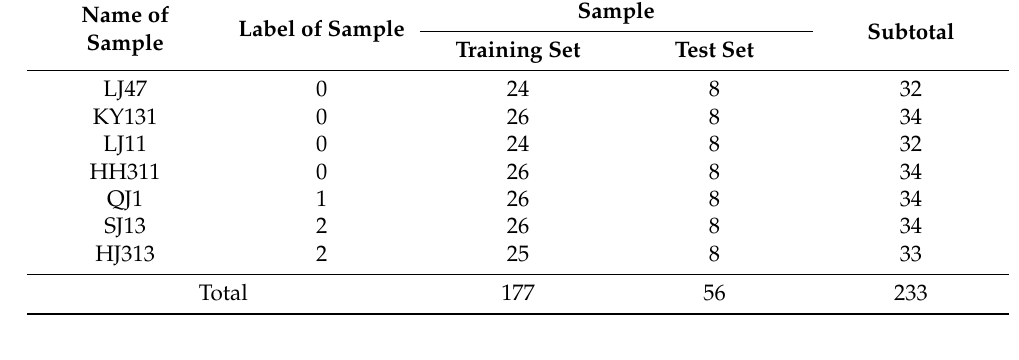
Table 2. Number of training samples and test samples with classification labels.